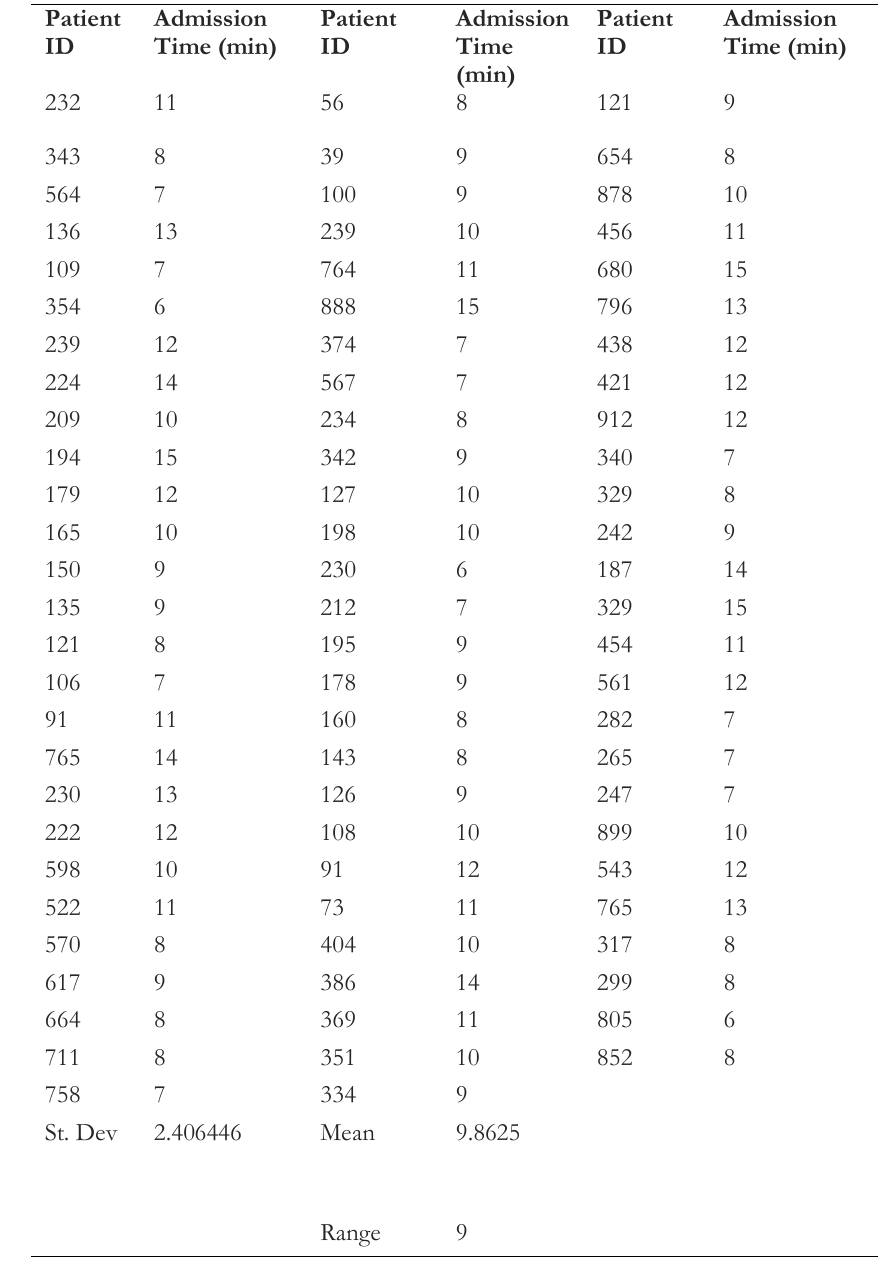
Table 6. Sample for measured data during study